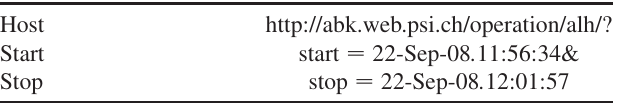
TABLE VI. Example URL to the alarm log Web interface.